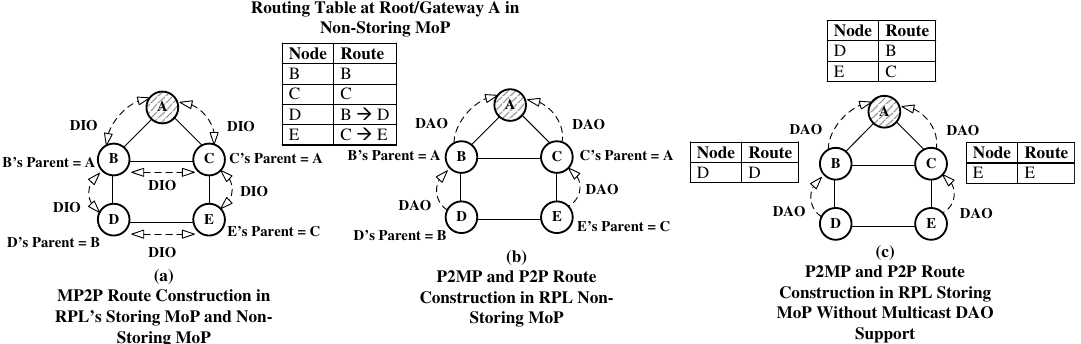
Figure 1. Routing Protocol for Low-Lower and Lossy Networks (RPL) Operation with Storing and Non-Storing Modes of Operation